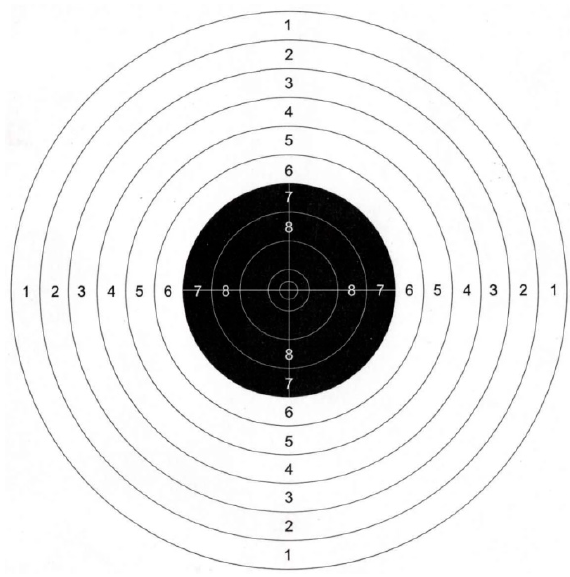
Figure 1. The 10-m air-pistol Figure 1. The 10-meter air-pistol task.